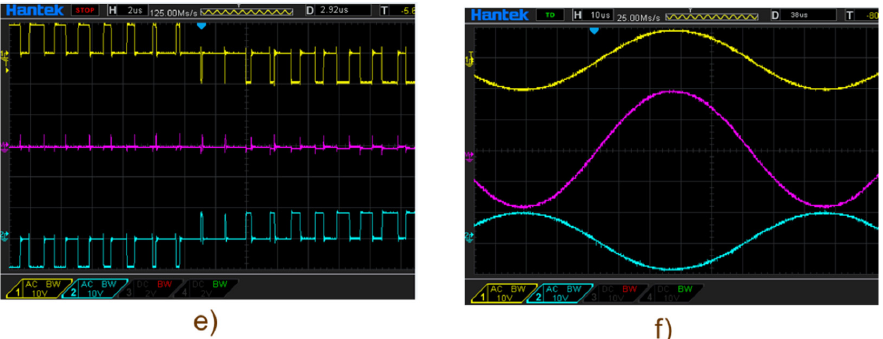
Figure 13. Oscillograms of the control signals generated by the hybrid 9 bit LBDD PWM modulator in Figure 4b with extended architecture with f c 1 = 328 kHz and f m = 30 kHz: ( a ) PWM L and PWM R signals; ( b ) S 1 and S 2 signals; ( c ) output voltages in DM and CM for amplifier from Figure 5 ( V DD =